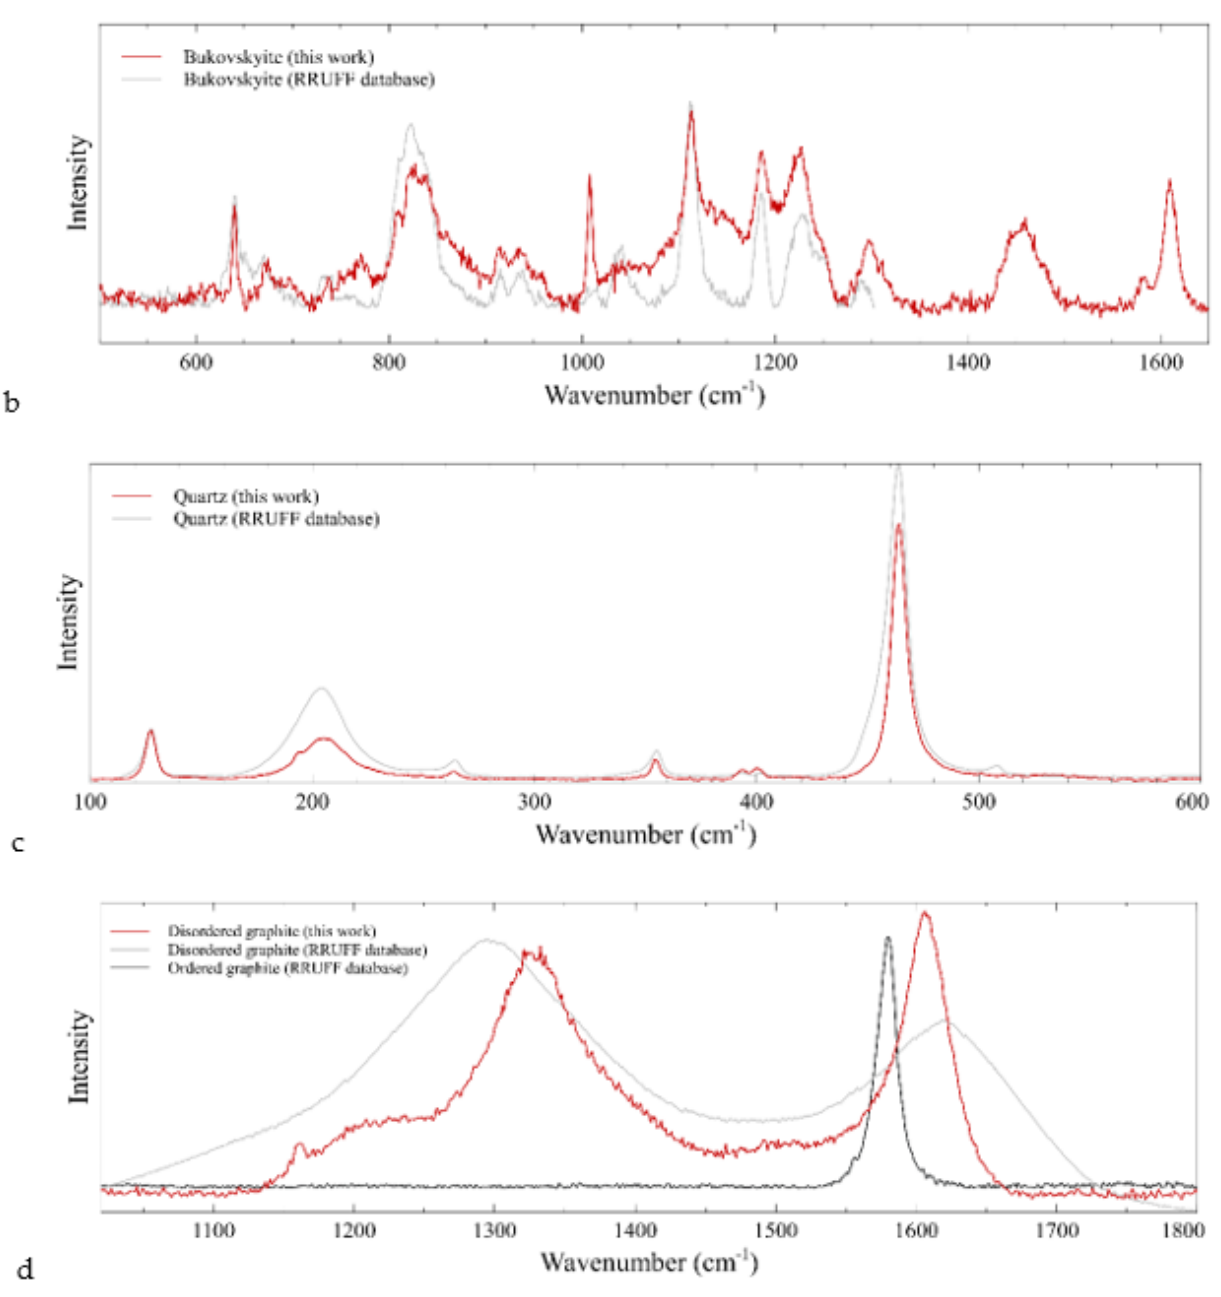
Figure 12. The Raman spectra of this work (red color) and the relative RRUFF database (grey color): ( a ) Raman spectra of anhydrite (416, 508, 612, 1129 cm − 1 ) [29,30,37]; ( b ) bukovskyite (814, 984, 1010, 1131, 1652 cm − 1 ) [29]; ( c ) quartz (128, 206, 263, 356, 465 cm − 1 ) [28,38]; and ( d ) disordered graphite (1340, 1620 cm − 1 ) [32,39] (Sample 2).